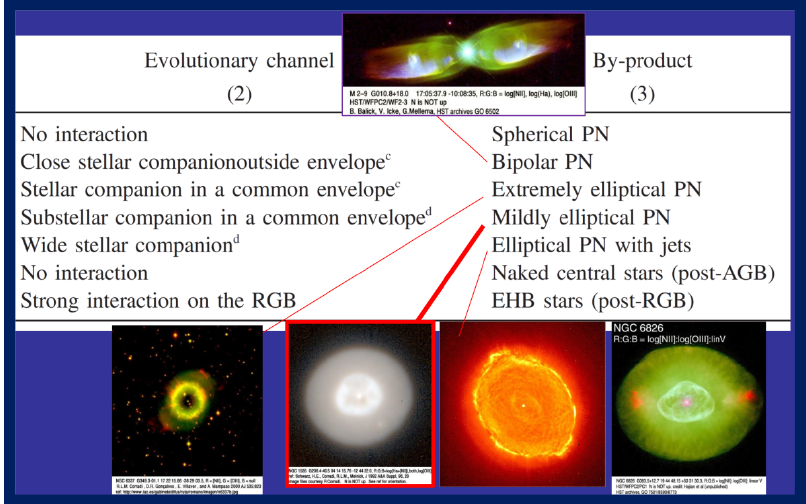
4 of 6 Figure 4. Observed transient events on the energy–time diagram. Blue empty circles represent the total (radiated plus kinetic) energy of the observed transients as a function of the duration of their eruptions, i.e., usually the time for the visible luminosity to decrease by 3 magnitudes. The Optical Transient Stripe is populated by ILOT events that we [18] suggest are powered by gravitational energy of complete merger events or vigorous mass-transfer events. For details of this figure, see http://phsites.technion.ac.il/soker/ilot-club/. 6. Planet-Shaped Planetary Nebulae When a planet spirals in inside the loosely bound envelope of an upper AGB star, it can excite waves in the envelope and spin up the envelope, both of which can cause asymmetrical mass loss. Finally, when the planet is destroyed near the core, it might lead to further asymmetrical mass loss from inside the envelope, e.g., jets that might be launched by the core. For example, a Jupiter-like planet might form a disk that launches jets with about a few percent of the mass of the planet. This amounts to the jets’ mass of about 5 few 10 M    . This mass is sufficient to form two opposite bullets (‘ansae’) along the symmetry axis of the nebula. I started the paper with the discussion of the general interaction of planets with evolving stars,